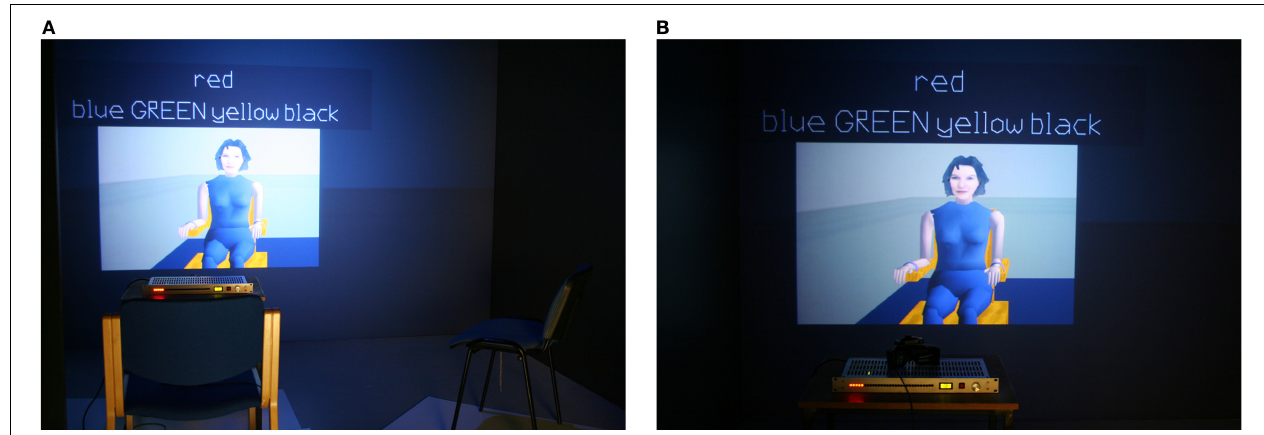
FIGURE 1 | Setup of the Milgram Paradigm in Virtual Reality (A) showing the layout of the Trimension Reactor system, and (B) the view from the point of view of the experimental